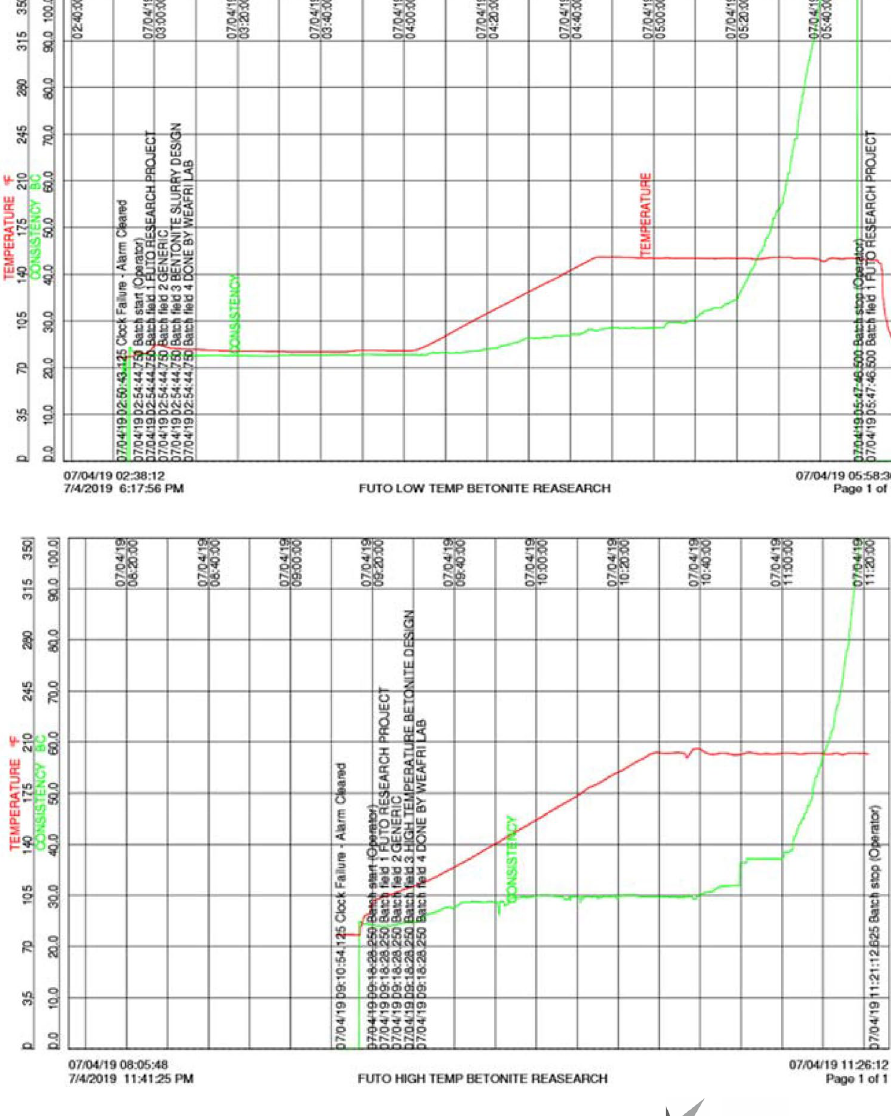
Fig. 6 Thickening time chart for